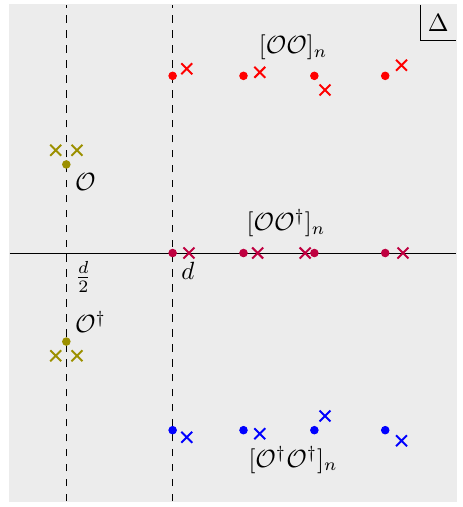
Figure 3 . Analytic structure of the spectral density I ∆ ,‘ =0 in the case of a free and a weakly-coupled theory in dS. The solid circles are the locations of the poles for “single-trace” and “double-trace” operators of the dS mean field theory. The single-trace poles appear for instance in the two-point function of the bulk field. The three families of double-trace poles are visible in different correlators, namely hOOOOi , hOO † OO † i and hO † O † O † O † i . After turning on interactions, the locations of the poles shifts, indicating that boundary operators pick up anomalous dimensions. These shifted poles are shown as crosses in the figure. Of course, new poles may appear